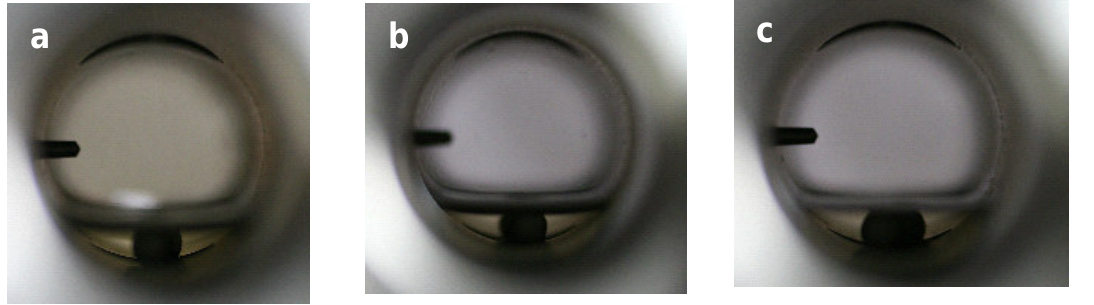
A dark body in the liquid phase is a Teflon